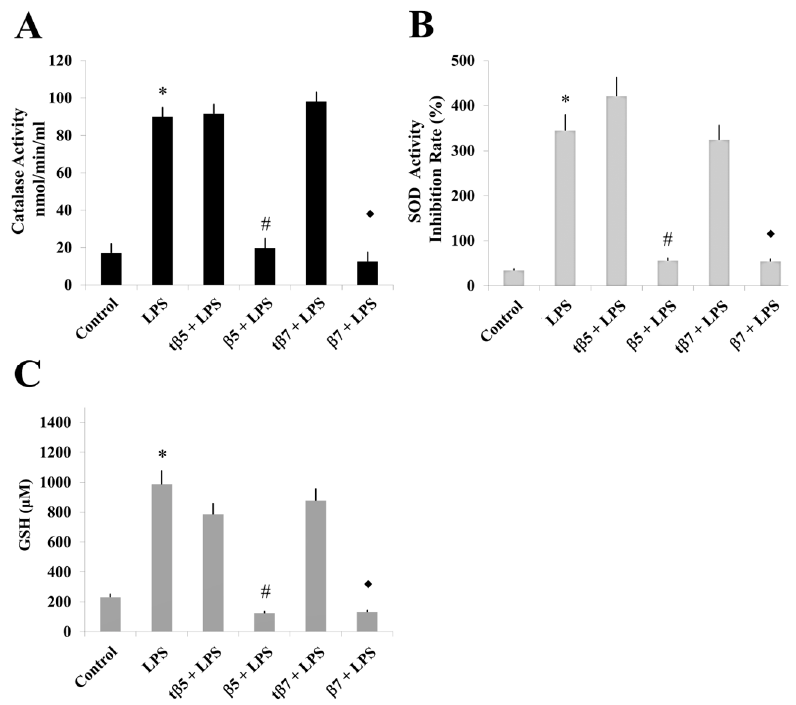
Figure 5. E ff ect of NLL β 5 and β 7 conglutins on CAT and SOD activities and GSH production in Type II diabetes (T2D) culture cells. CAT ( A ) and SOD ( B ) activities and GSH production ( C ). ★ p ˂ 0.05 T2D vs. t β 5 or t β 7; ★★ p ˂ 0.05 β 5 vs. T2D; ++ p ˂ 0.05 β 7 vs. T2D. Data represent mean ± SD from three independent experiments.